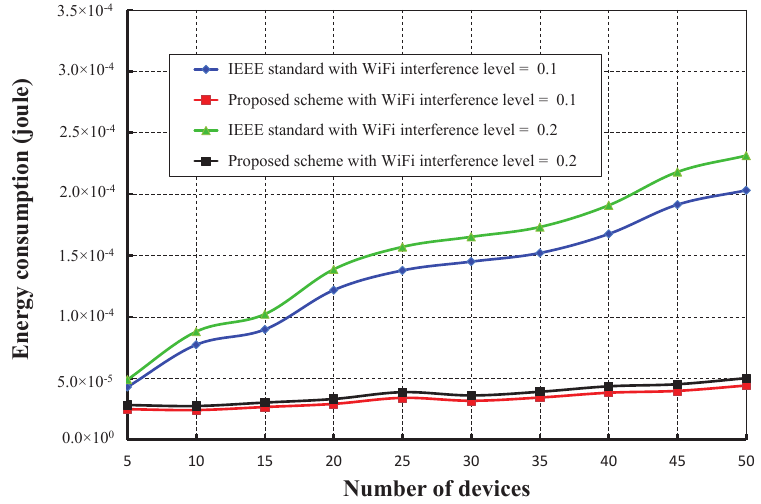
Figure 21. Comparison of the energy consumption of our proposed scheme with the IEEE 802.15.4e standard under different WiFi interference levels.